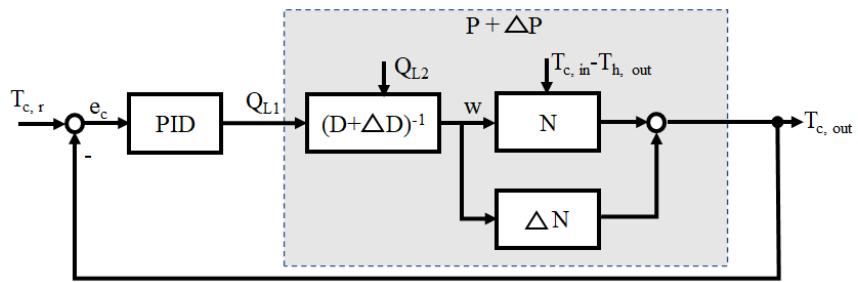
Figure 10. Fractional order robust control with PID.